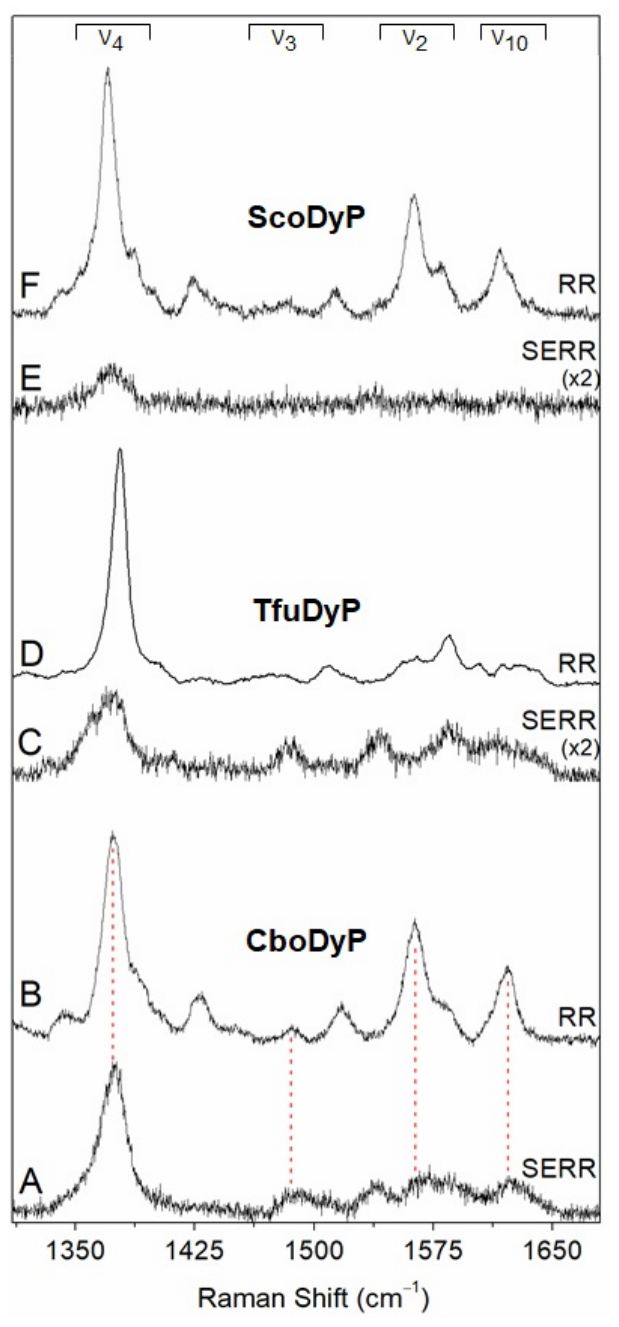
Figure 2. Resonance Raman (RR) and surface-enhanced resonance Raman (SERR) spectra of ferric dye-decolorizing peroxidases (DyPs): ( A ) SERR spectrum of CboDyP immobilised on Ag electrodes coated with 1-undecanethiol:11-amino-1-undecanethiol hydrochloride (M:M, 2:1) self-assembled monolayer (SAM) at pH 7, recorded at +250 mV electrode poised potential; ( B ) RR spectrum of CboDyP in solution at pH 8; ( C ) SERR spectrum of TfuDyP immobilised on Ag electrodes coated with 1-undecanethiol: 11-amino-1-undecanethiol hydrochloride SAM (M:M, 2:1) at pH 7, recorded at +350 mV electrode poised potential; ( D ) RR spectrum of TfuDyP in solution at pH 7.5; ( E ) SERR spectrum of ScoDyP immobilised on a 1-undecanethiol SAM at pH 7, recorded at +250 mV electrode poised potential; ( F ) RR spectrum of ScoDyP in solution at pH 8. The RR spectra of CboDyP (at 21 °C) and ScoDyP (at − 50 °C) were acquired with 405 nm excitation, and the RR spectrum of TfuDyP (at 21 °C) was obtained with 413 nm excitation. All SERR spectra were acquired with 405 nm excitation at 21 °C ( vide infra Materials and Methods).